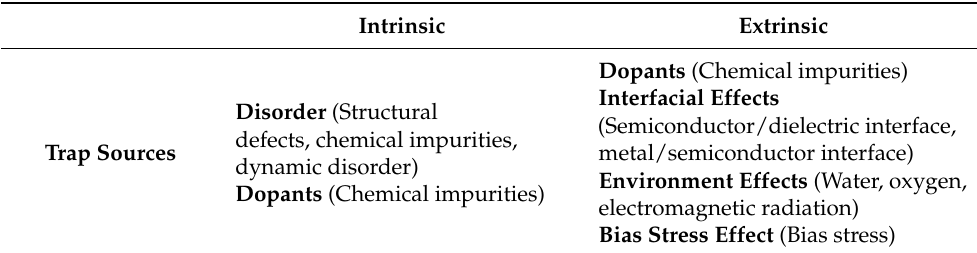
Table 2. Summary of origins of charge traps in OFETs